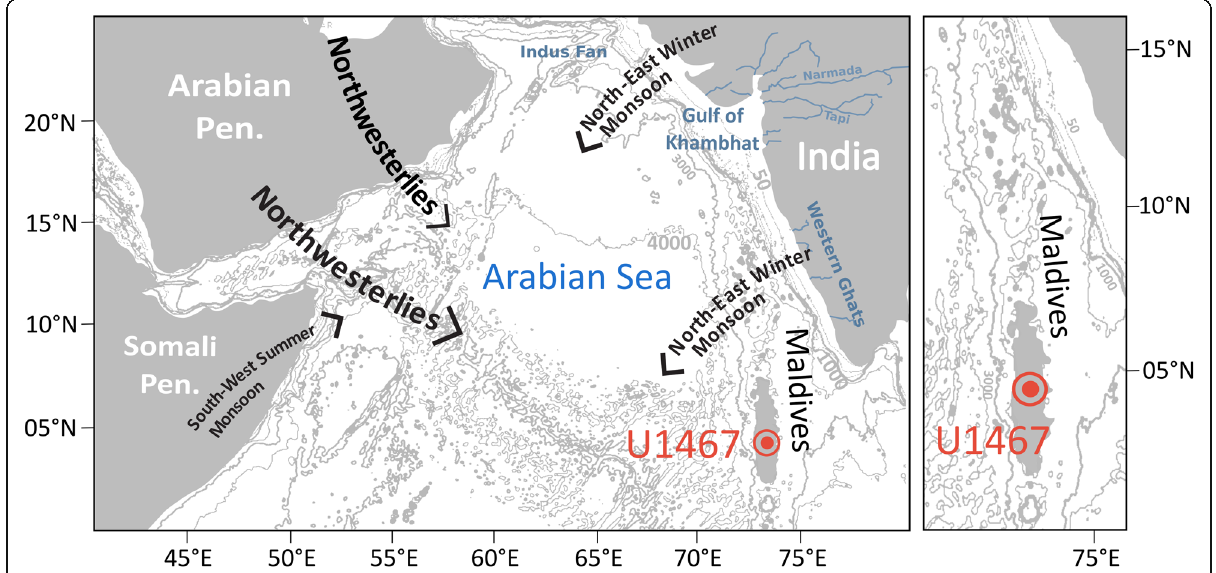
Fig. 2 Drilling location of Site U1467 in the Maldives Archipelago. The modern monsoon wind pattern over the Arabian Sea; showing the northwesterlies, the summer monsoon south-western winds and the north-eastern winter monsoon winds. The size of the arrows indicates relative wind strength. Adapted from Leuschner and Sirocko